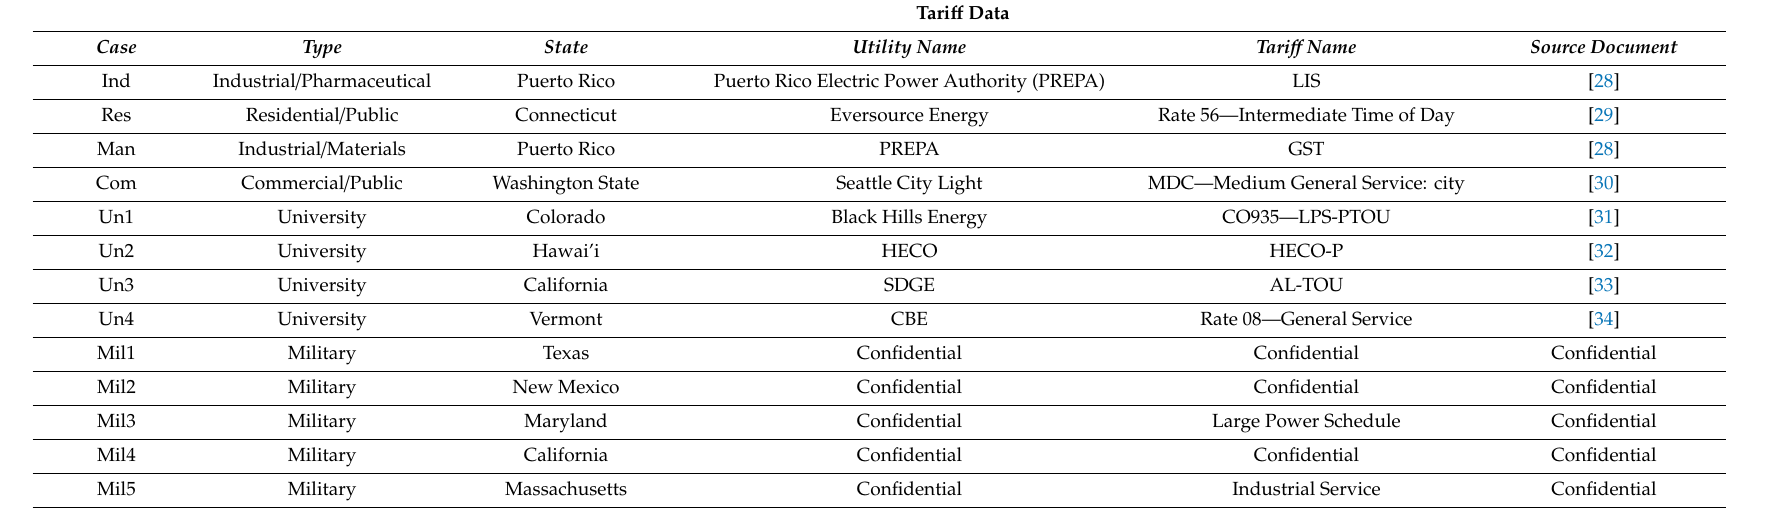
Table A1. Summary of electric tari ff s and supporting